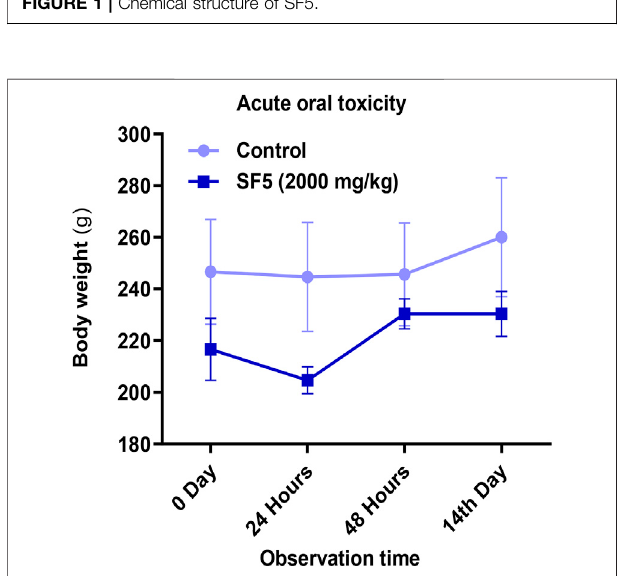
FIGURE 2 | Effect of SF5 on body weights of rats in different toxicity